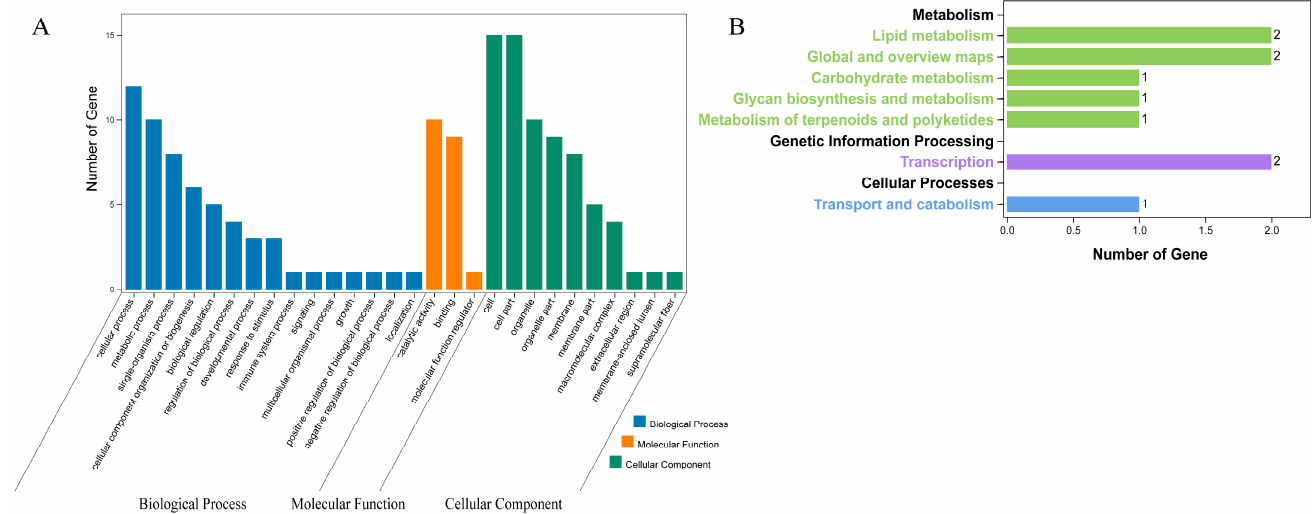
Figure 6. Annotation results. ( A ) GO terms enriched with SmBBXs , ( B ) KEGG pathway terms enriched with SmBBXs .